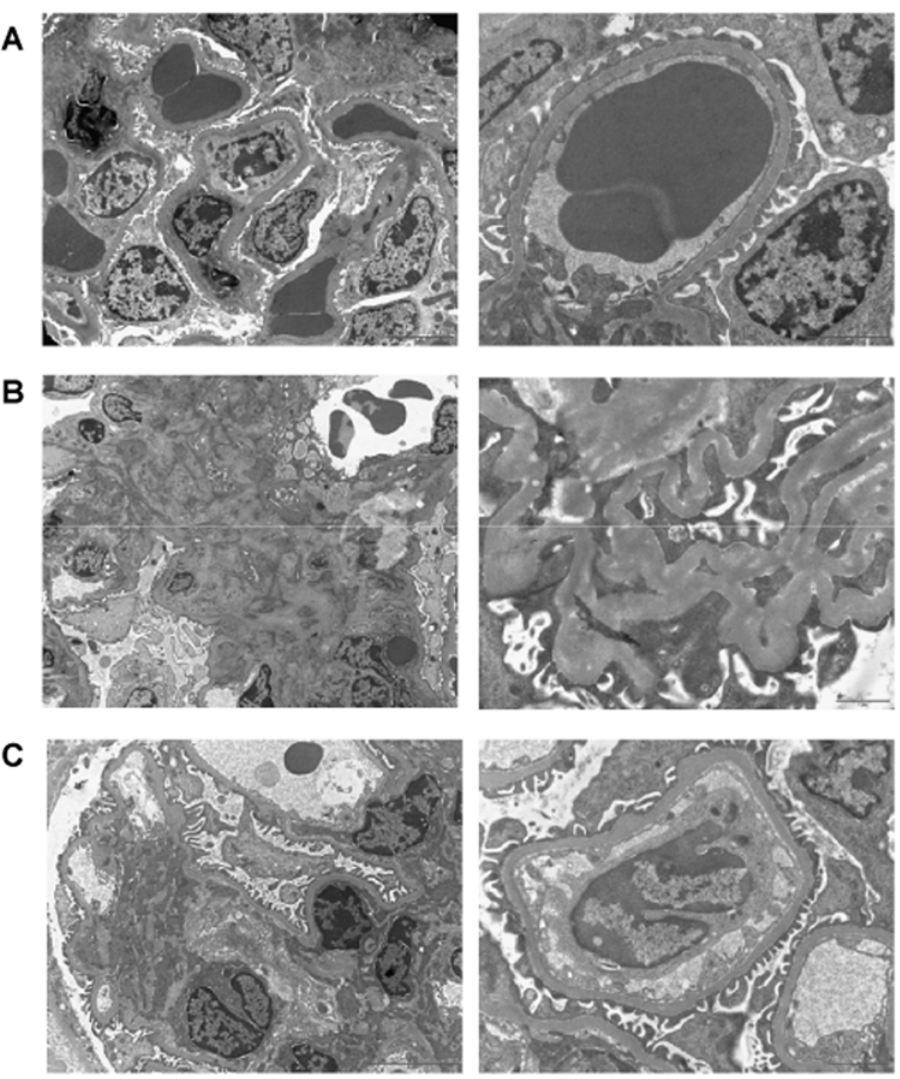
Figure 5. Restoration of podocyte structure following AT1 receptor antagonism. Representative examples of ultrastructural analysis performed by electron microscopy in wild type (A) and RenTg mice before (B) and after (C) irbesartan treatment. The structural alterations of podocytes in RenTg mice such as loss of podocyte foot processes and abnormal thickness of the basal membrane (B) were substantially improved after antagonism of the AT1 receptor (C). Bar=2 m m.